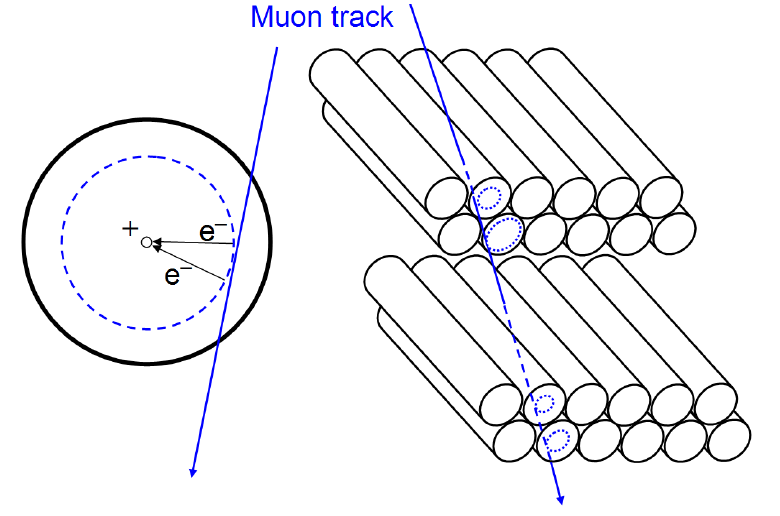
Figure 9. Schematic illustration of muon tracking with drift